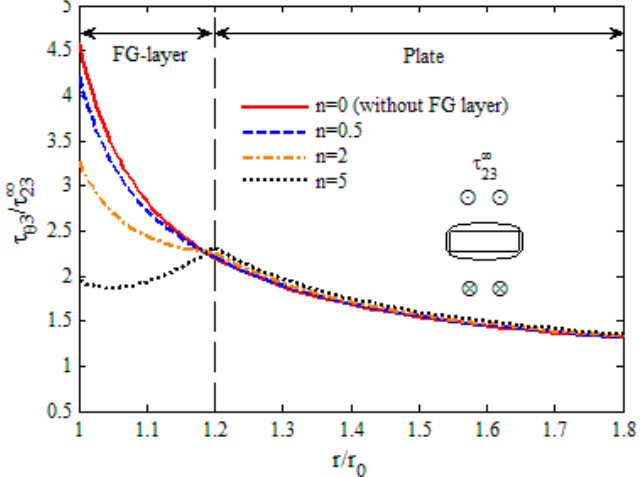
Figure 11. The variation in shear stress τ θ 3 along the normal direction of the hole (square, δ = 45 ◦ ).